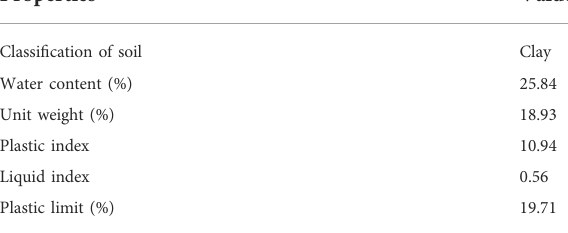
TABLE 1 Physical properties of the soil. TABLE 2 Physical properties of lignin fi